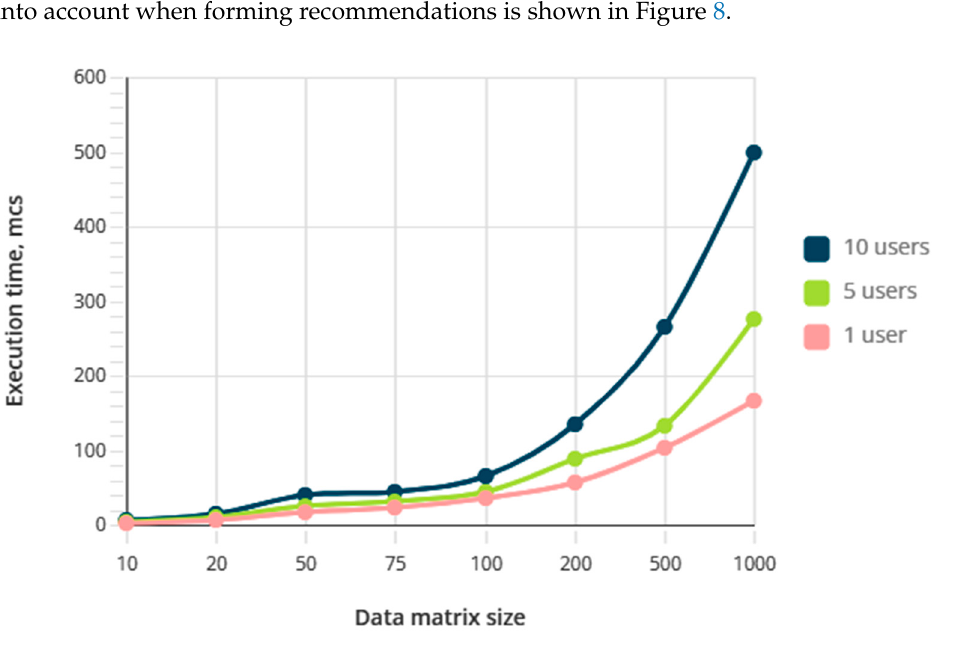
Figure 8. Execution time for the Funk SVD algorithm depending on the number of users involved in providing recommendations.